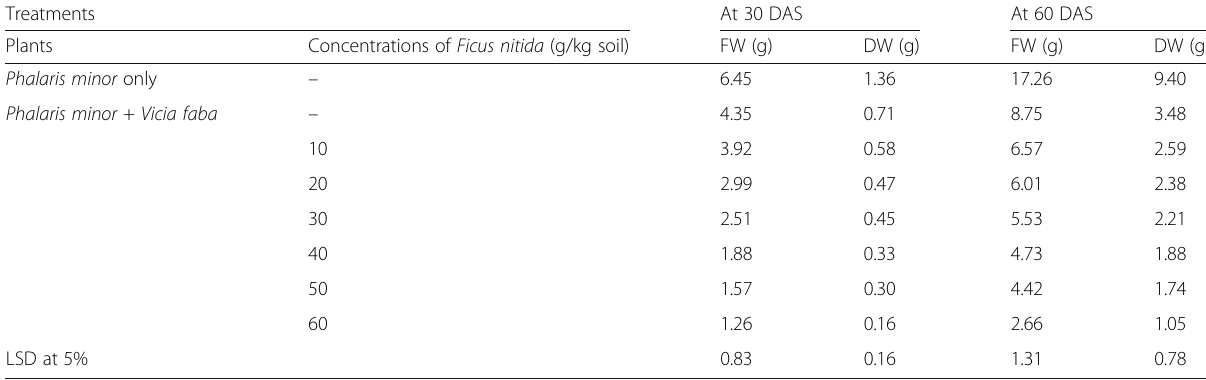
Table 1 Effect of Ficus nitida leaf powder on fresh and dry weight of grassy leaved weed Phalaris minor associated with Vicia faba plants (average of the two seasons) Treatments At 30 DAS Plants Concentrations of Ficus nitida (g/kg soil)